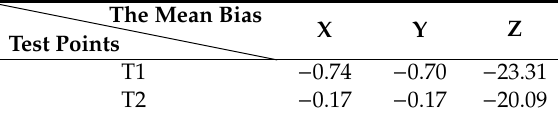
Table 2. The mean parameter estimator bias (10 − 3 cm).